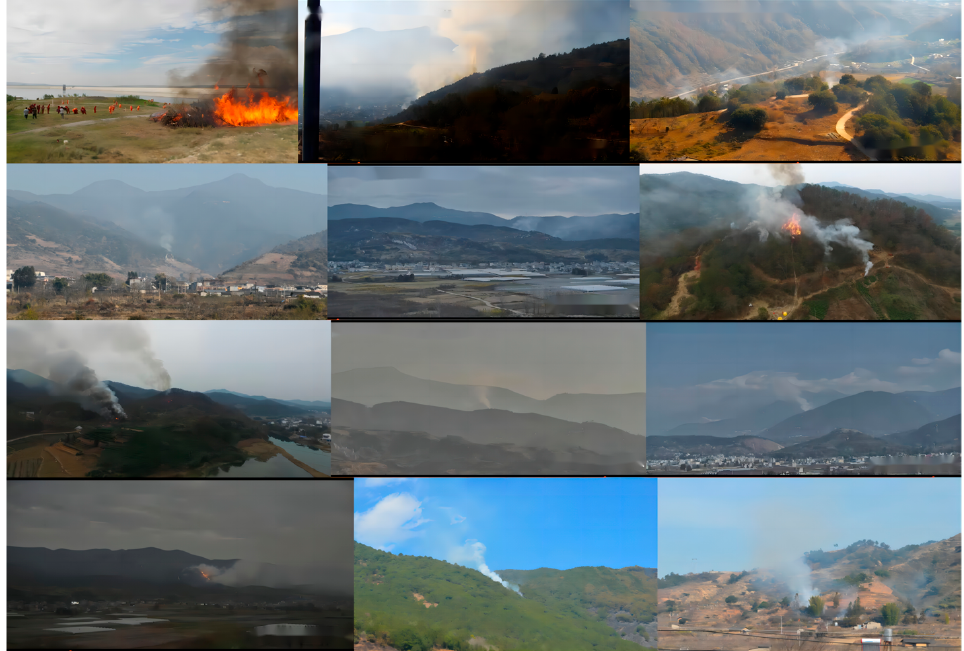
Figure 3. Example of part of the used data. Table 4. Forest fire